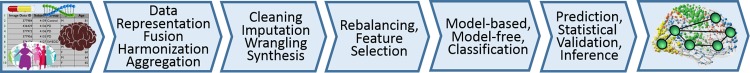
Overview of the complete analytics protocol (from data handling, to pre-processing, modeling, classification and forecasting).